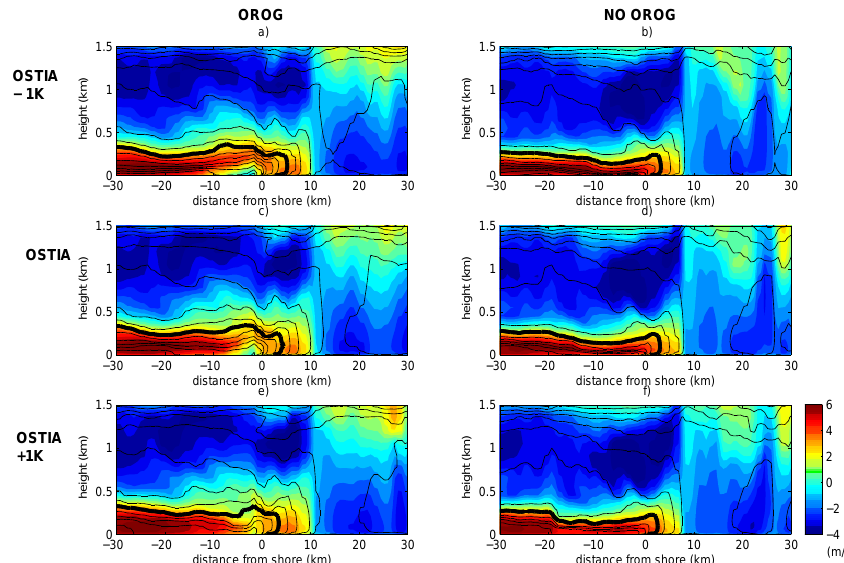
Fig. 8. Vertical cross sections along a SW–NE transect through Lyme Bay at 15:00UTC. The section-parallel wind component (filled contours) and isentropes (black contours, every 0.5K) are shown for each of the perturbed-SST simulations with and without orography. For reference, the thick black contour is the 291K isentrope. Height corresponds to the terrain following model